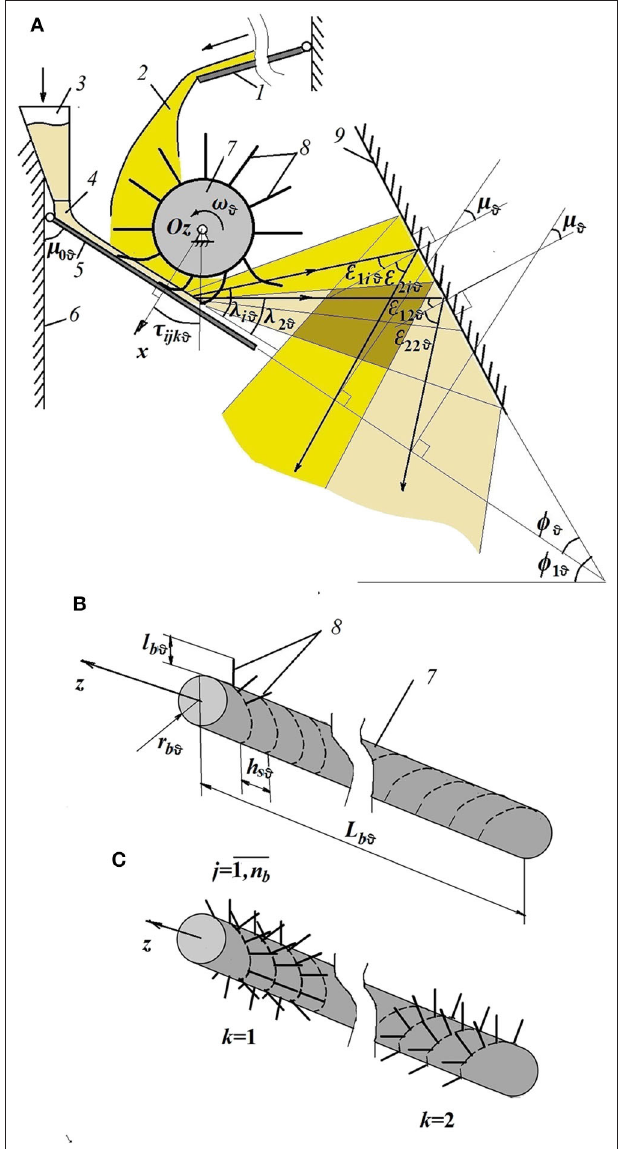
FIGURE 1 | Conditional schemes: (A) for the intermediate stage of mixing ( τ = ϑ ) of bulk components ( i = 1 , 2 ) in the gravitational apparatus when their flows interact with the brush elements j = 1 , n b (step 1) and the bump surface (step 2): 1—inclined tray; 2—the flow of the granular mixture after the stage τ = ϑ − 1 with the preliminary composition of two components ( i = 1 , 2 ) in the ratio of their volumes Ω 1 , ϑ − 1 /Ω 2 , ϑ − 1 = α 1 , ϑ − 1 /α 2 , ϑ − 1 ; 3—hopper dispenser; 4—the flow of the key loose component ( i = 2 ) with the volume ( Ω 2 , ϑ − (cid:127) 2 , ϑ − 1 ) corresponding to the increment of the fraction of this component 1α 2 , ϑ = α 2 , ϑ − α 2 , ϑ − 1 ; 5—inclined tray; 6—wall of the housing; 7—drum; 8—brush elements; 9—bump surface; (B) for drum 7; (C) for drum 7 and brush elements 8. The copyright holder of the patents referenced here is